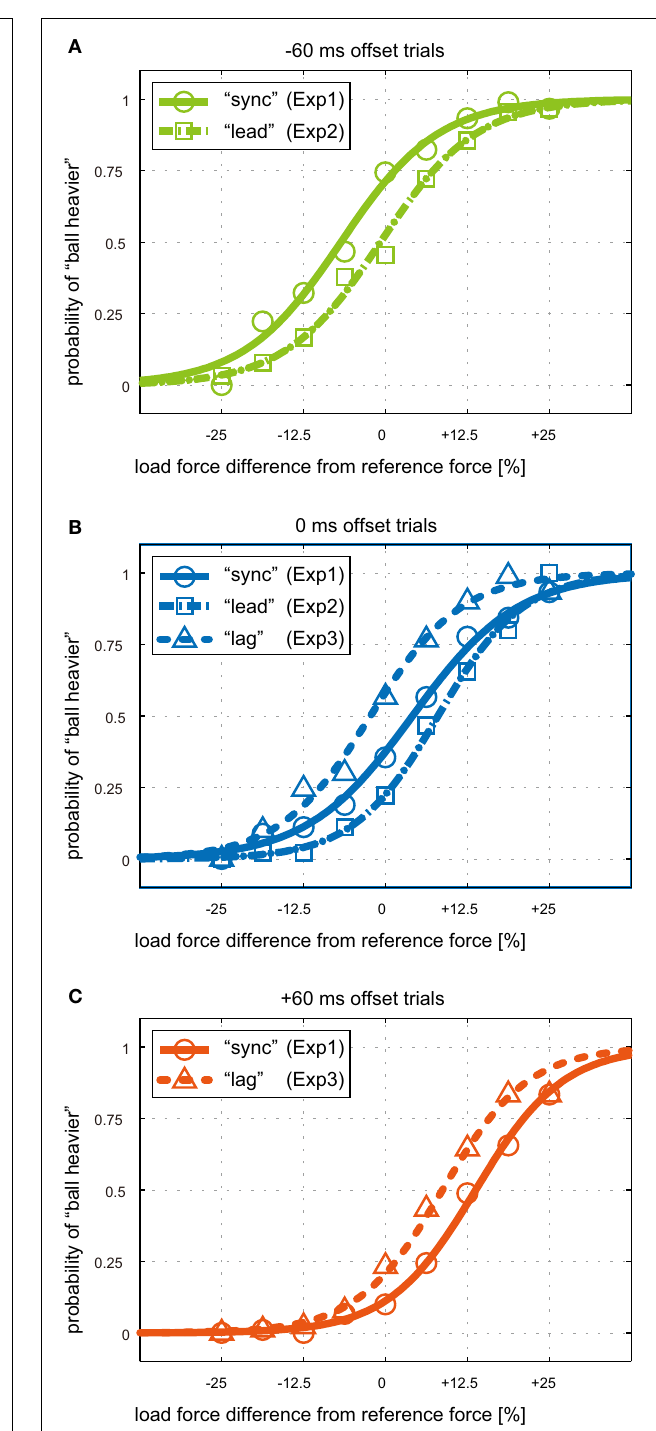
FIGURE 7 | Group-average psychometric curves for weight judgment in the three experiments. Psychometric curves for (A) − 60ms offset trials, (B) 0ms offset trials, and (C) + 60ms offset trials in theWeight Perception Test sessions. Offset values are positive in the case where force was applied after visual contact.The horizontal axes represent the percent difference in load force magnitude from the reference force. Green, blue, and red colors represents − 60, 0, and + 60ms time offsets. Solid, dash-dotted, and dotted lines correspond toWeight PerceptionTest sessions after “sync,” “lead,” and “lag” conditioning,